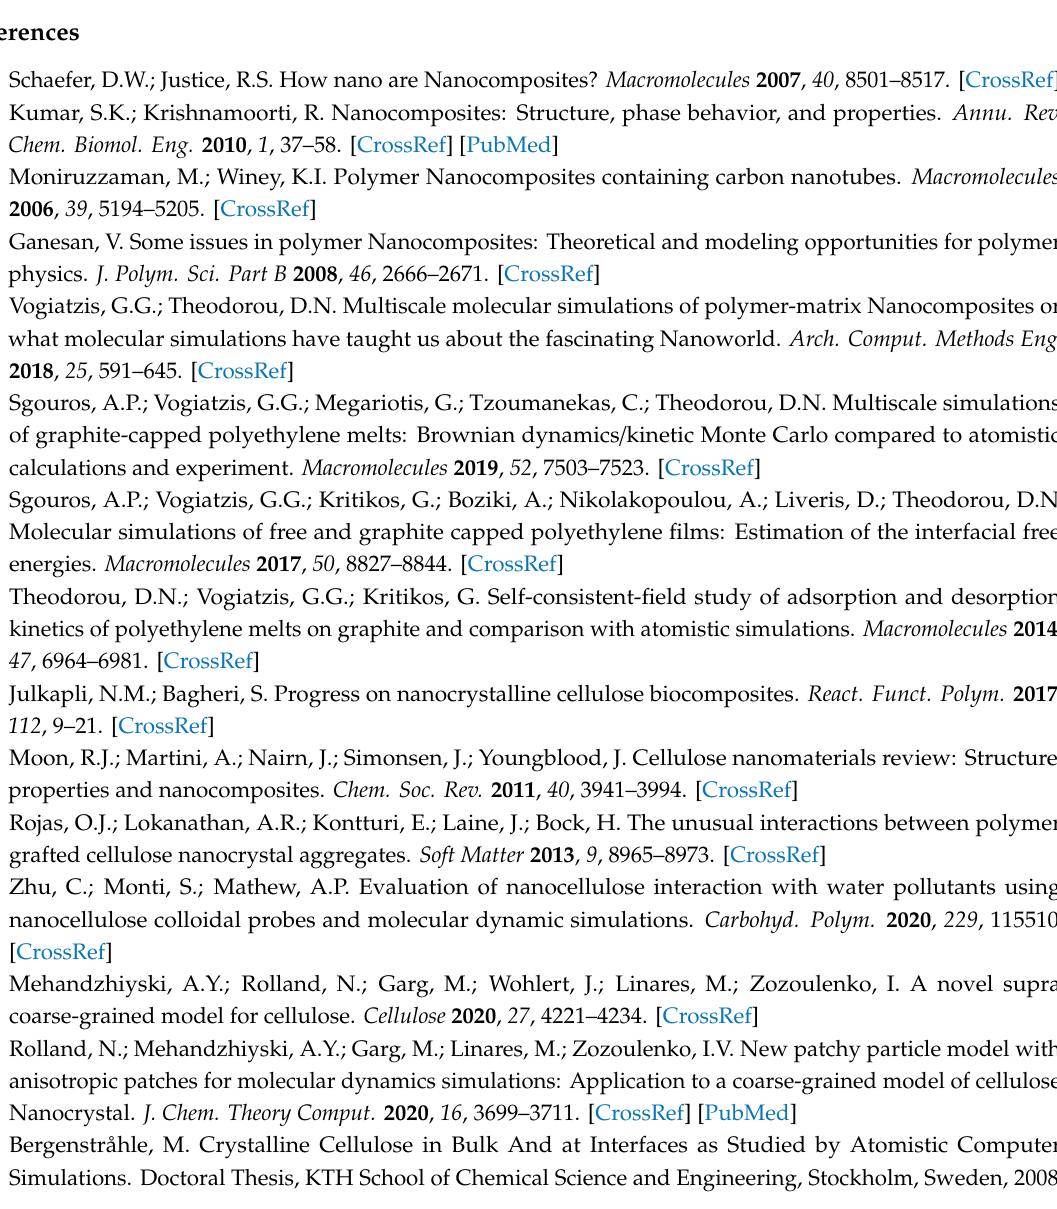
Figure S1. Time dependence of the system temperature. Figure S2. The instant snapshots of System 6 at 7 ns (a) and 7.8 ns (b). These snapshots explain the jump in NC(t) at ≈ 7.5